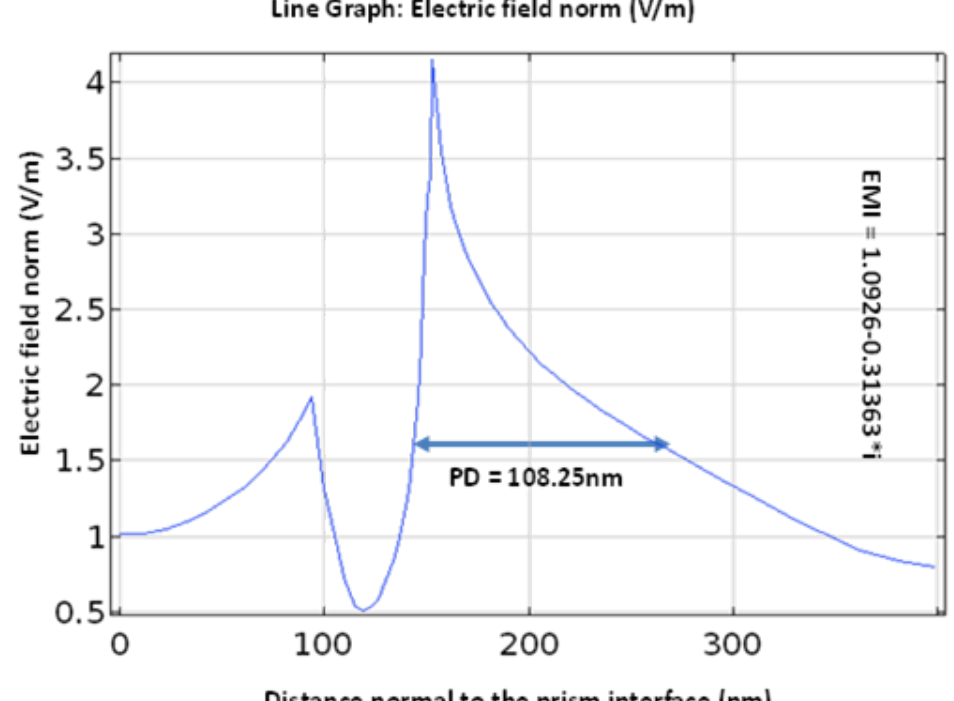
Figure 9. Penetration depth variation and transverse magnetic field.